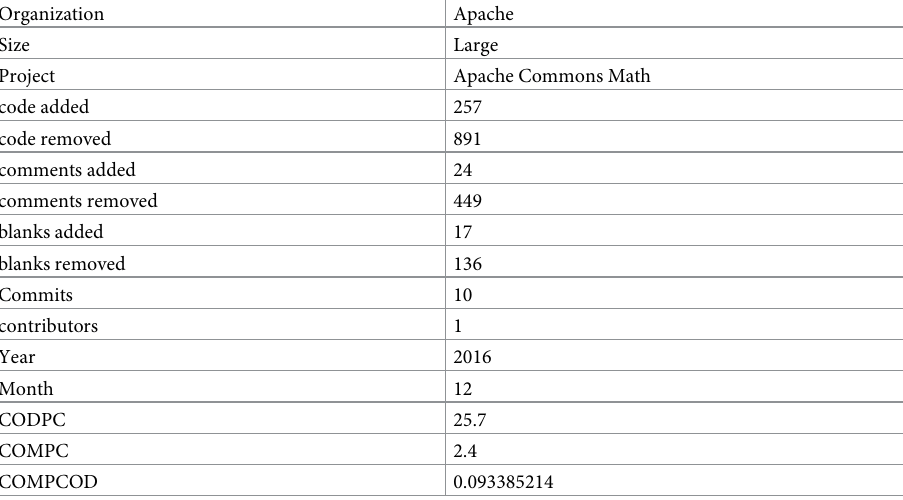
Table 2. Example of collected data